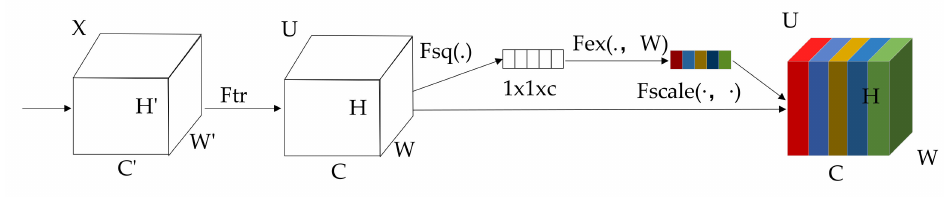
Figure 4. Structure of the channel-attention